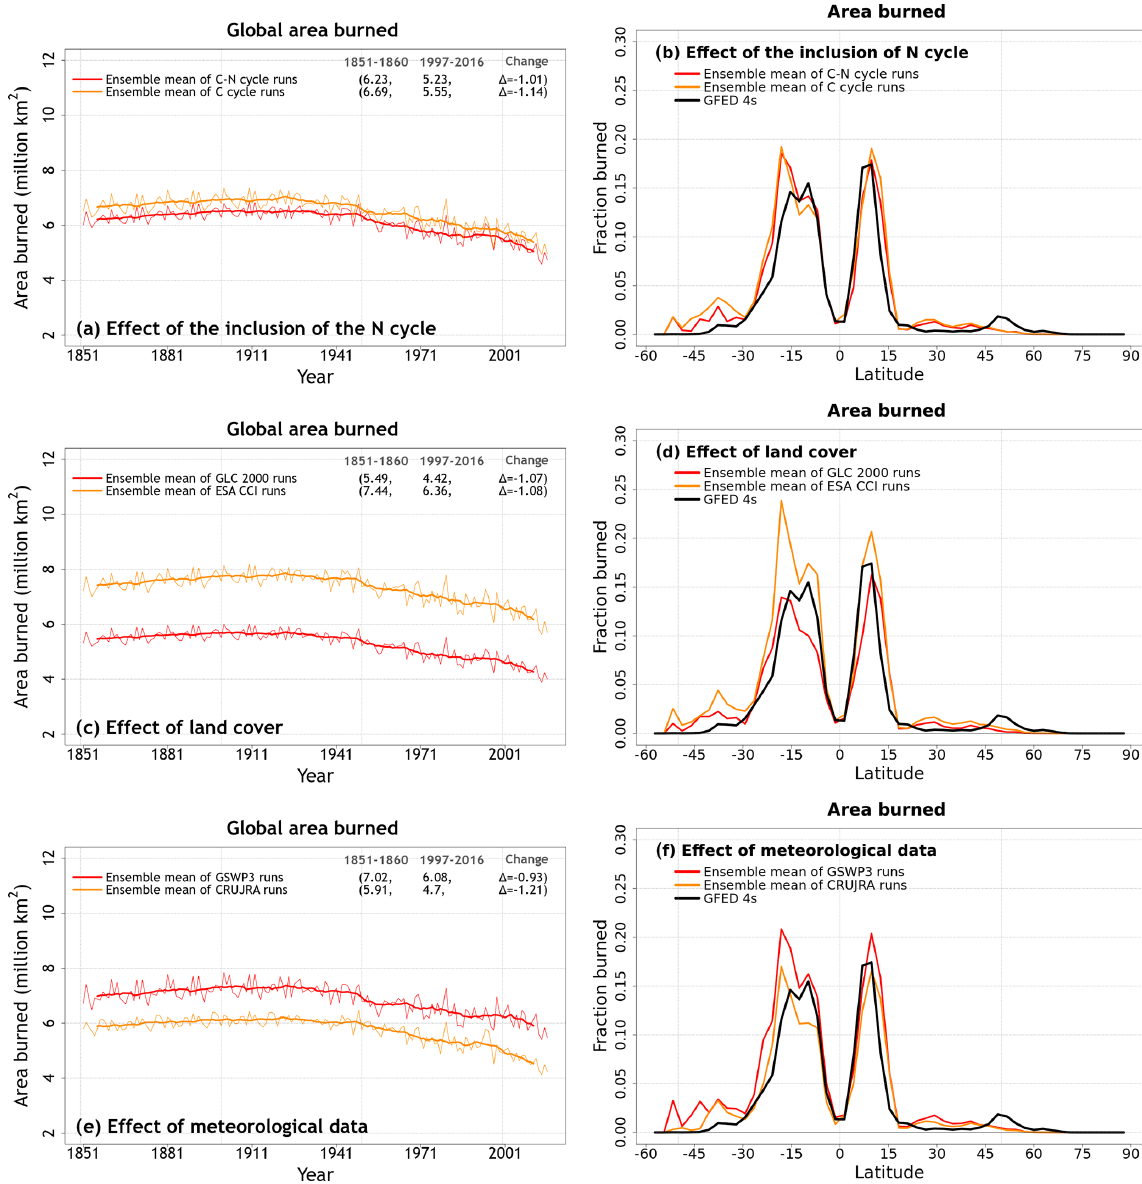
Figure 8. Time series of annual area burned (over all land area excluding Greenland and Antarctica) (a, c, e) and zonally averaged values of area burned (d, e, f) averaged, for the period 1997–2016, over the four ensemble members that are driven with and without an interactive N cycle (a, b) , that are driven with the GLC 2000 and ESA CCI based land cover representations (c, d) , and that are driven with GSWP3 and CRU-JRA meteorological data (e, f) . The thin lines for the time series show the individual years, and the thick lines show their 11-year moving average in (a, c, e) . Model values averaged over the pre-industrial (1851–1860) and present-day (1997–2016) time periods, and their difference, are also shown for (a) , (c) , and (e)